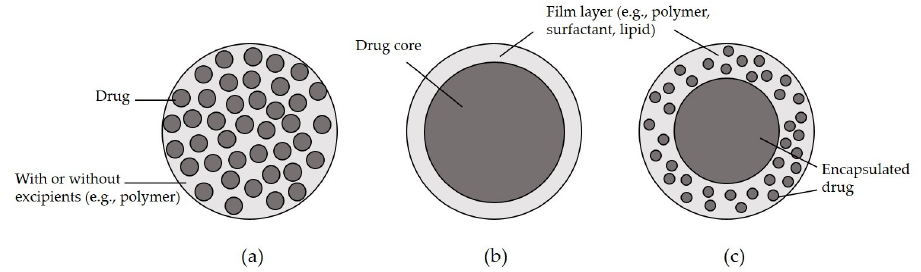
Figure 1. Different types of nano-/microparticle structures: ( a ) matrix, ( b ) core-shell, and ( c ) mixed type of matrix and core-shell.